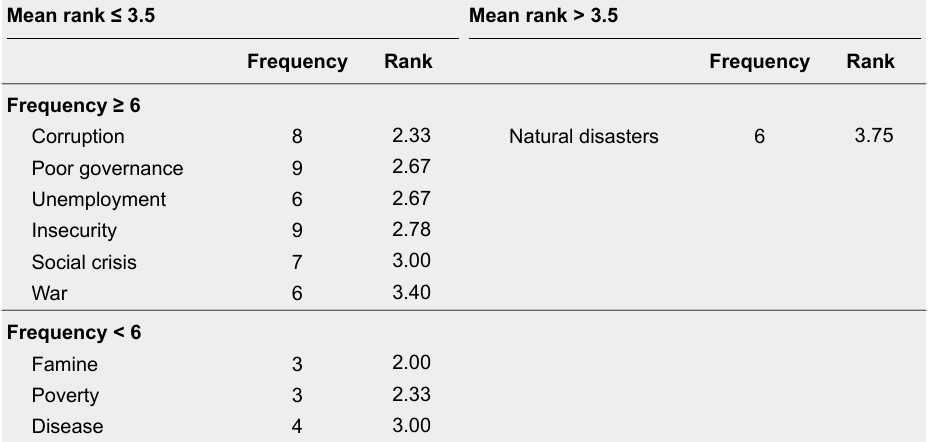
Mean rank > 3.5Mean rank ≤